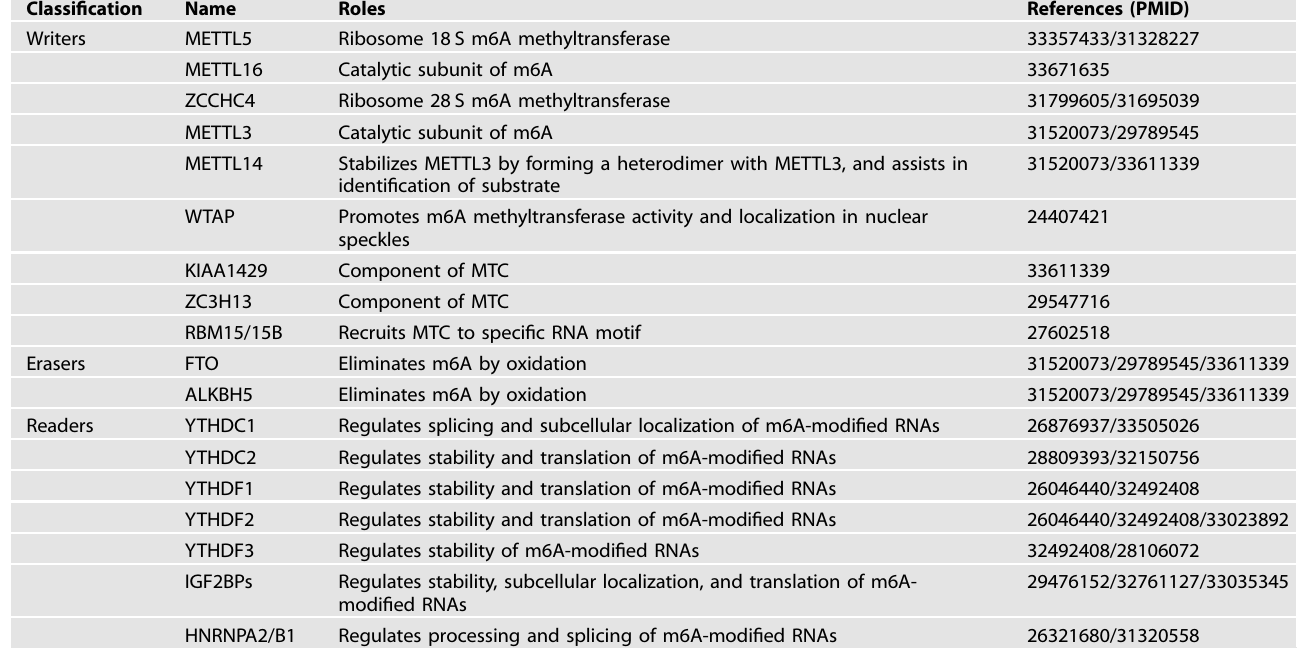
Table 1. Writers, erasers and readers of RNA m6A modi fi